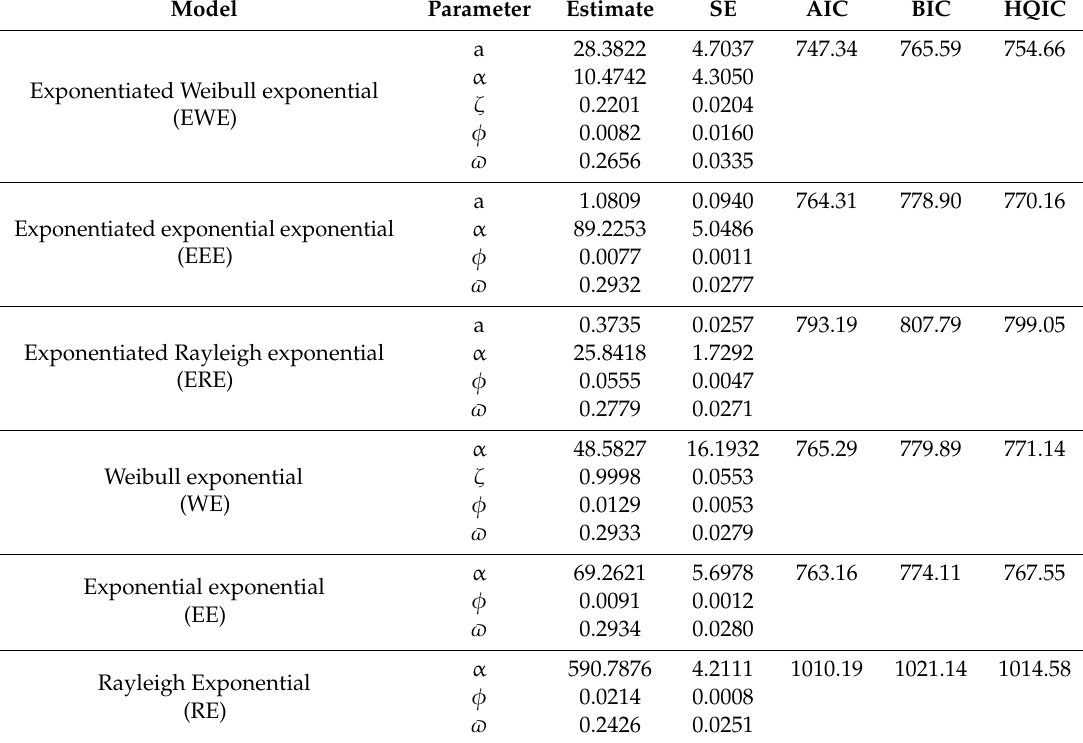
Table 2. Results of maximum likelihood estimates, considering the bounded cumulative hazard (BCH) model for e1684 data without covariates.